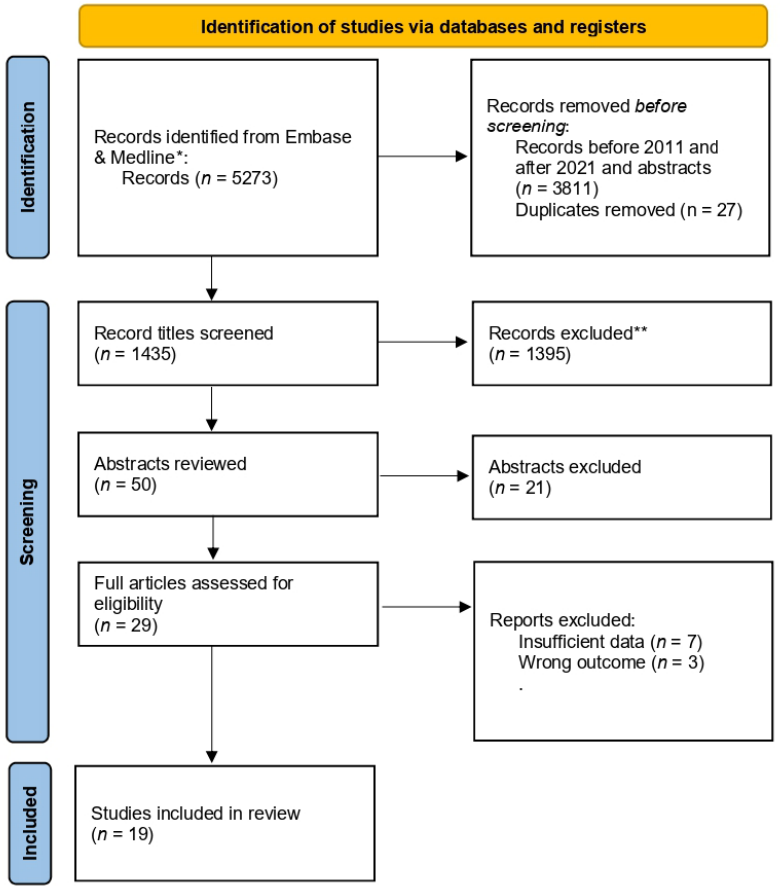
Figure 1. PRISMA flow diagram “Financial toxicity, quality of life and survival” (dated 25 March